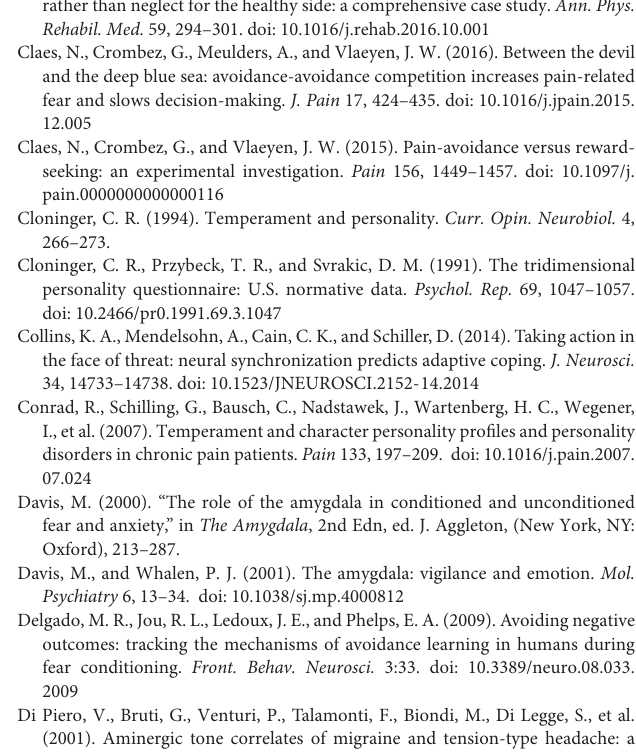
whether to continue painting with the pain stimulus or to stop painting with no pain stimulus. FIGURE S2 | (A) Mean avoidance time. The average time of stopping movement (avoidance from pain) (mean ± SE). ACQ: acquisition phase, TEST1: first set of test phase, TEST2: second set, TEST3: third set, TEST4: fourth set of the test phase. # p < 0.01, cluster 1 vs. cluster 2. Based on the results of the cluster analysis (Ward’s method), the subjects could be divided into the following two subgroups: cluster 1 ( n = 6) and cluster 2 ( n = 18). We compared the clusters and observed that the avoidance times of cluster 1 subjects were significantly longer than those of cluster 2 subjects in all phases (acquisition phase, p = 0.0009; first set of the test phase, p = 0.0002; second set, p = 0.0006; third set, p = 0.0004; and fourth set, p = 0.007). (B) Mean startle amplitudes. Mean eyeblink startle amplitudes (mean ± SE). Note that for graphic purposes, T -scores were used. PRA: practice phase. ∗ p < 0.0045, practice phase vs. the other phases. In our comparison of the startle responses in six blocks, the Friedman test showed a significant main effect ( χ 2 = 53.88, p < 0.001). The post hoc test showed that for all 24 subjects, the startle response in the acquisition phase was significantly higher than that in the practice phase ( p < 0.001) but the startle response for all test phases was not significantly different from that of the practice phase (first set of the test phase, p = 0.002; second set, p = 0.72; third set, p = 0.79; fourth set, p = 0.08). Moreover, in all phases or sets, there were no significant differences between the two clusters. FIGURE S3 | (A) The correlation between the total times of pain-inhibited movements and the mean startle amplitudes ( T -scores) of the ACQ and TEST phases. (B) The correlation between the total times of approach movements and the mean startle amplitudes ( T -scores) of the ACQ and TEST phases. (C) The correlation between the total times of pain-inhibited movements and the mean startle amplitudes ( T -scores) of the EXT phase. (D) The correlation between the total times of approach movements and the mean startle amplitudes ( T -scores) of the EXT phase. Pearson’s correlation coefficient was used for the